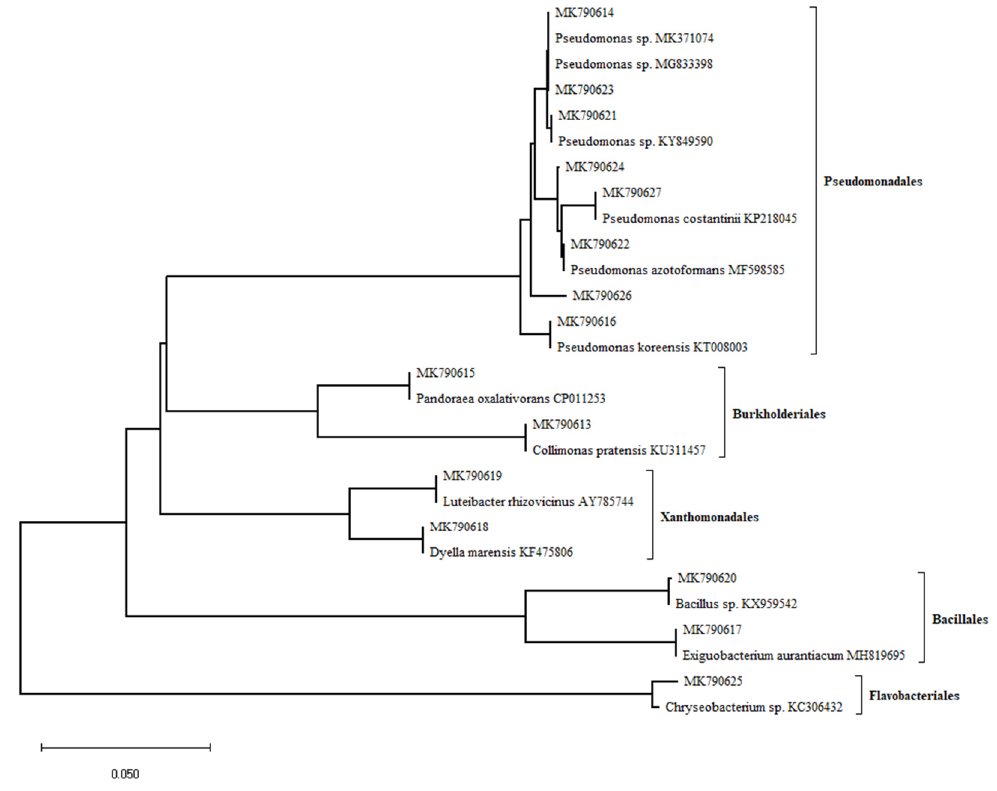
Figure 2. Maximum-likelihood tree of 16S rRNA gene sequences of bacterial isolates, showing relationships in terms of distance. Numbers near branches refer to bootstrap support values. Names in capital letters between branches refer to bacterial phyla.